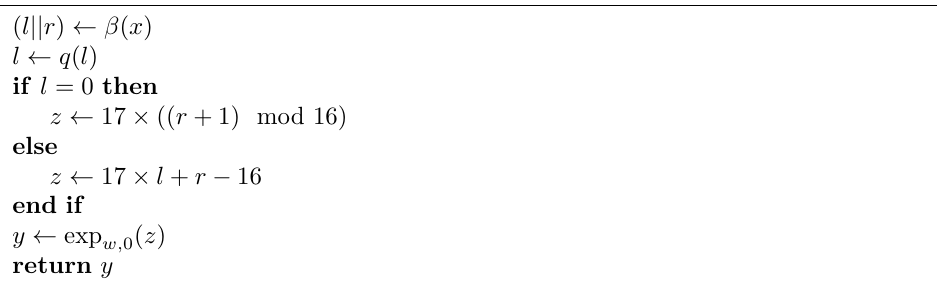
Algorithm 1 Computing the inverse of 𝜋 : 𝑦 = 𝜋 − 1 ( 𝑥